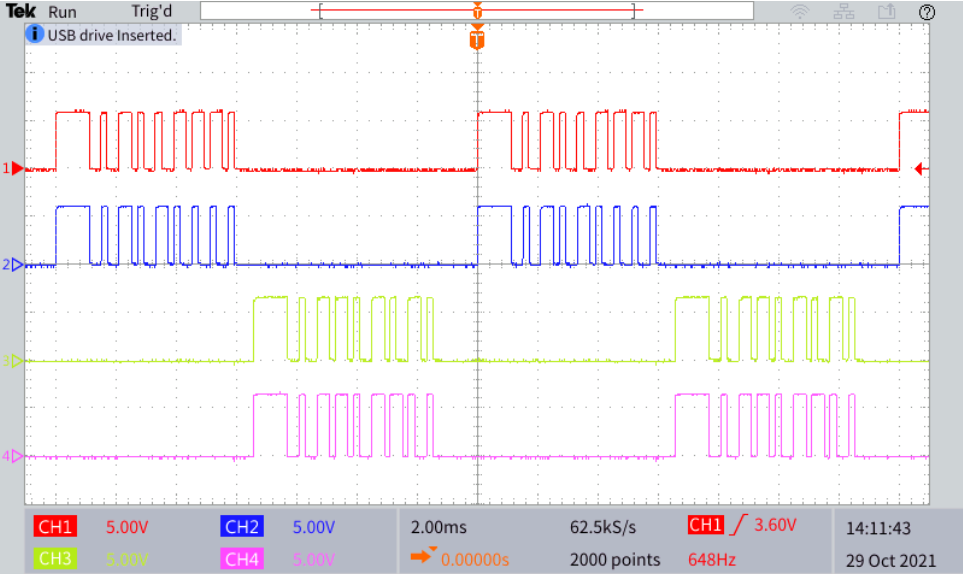
Figure 5. Example of waveforms of V r and V c on two adjacent rows ( top ) and two adjacent columns ( bottom ), respectively. Voltages are either 0V or 6.4V; thanks to a multi-phase bridge, the robot is able to extract the | V r − V c | to power itself. The first long pulse of each burst is the start signal: the last pulse is the stop bit, always 0 . The code shown by the red trace is 01001110b : this means lane 010b = 2 (even, this means that it is a row), line (row, in this case) 0111b = 7, stop bit 0 ; similarly, for the blue trace the code is 01010000b , i.e., lane 010b = 2, row 1000b = 8, stop bit 0 . Similarly, the code shown by the green trace is 01101010b : this means lane 011b = 3 (odd, this means that it is a column), line (column, in this case) 0101b = 5, stop bit 0 ; similarly, for the pink trace the code is 01101100b , i.e., lane 011b = 3, column 0110b = 6, stop bit 0